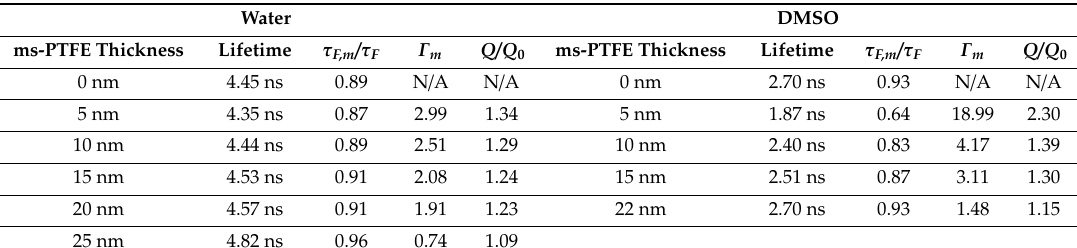
Table 1. Lifetime characteristics of riboflavin in respective environments and their implications on quantum yield enhancement ( Q / Q 0 ). Lifetimes were experimentally measured; all other characteristics were computed using Equations (1)–(5), neglecting the e ff ect of k m . Water DMSO ms-PTFE Thickness Lifetime